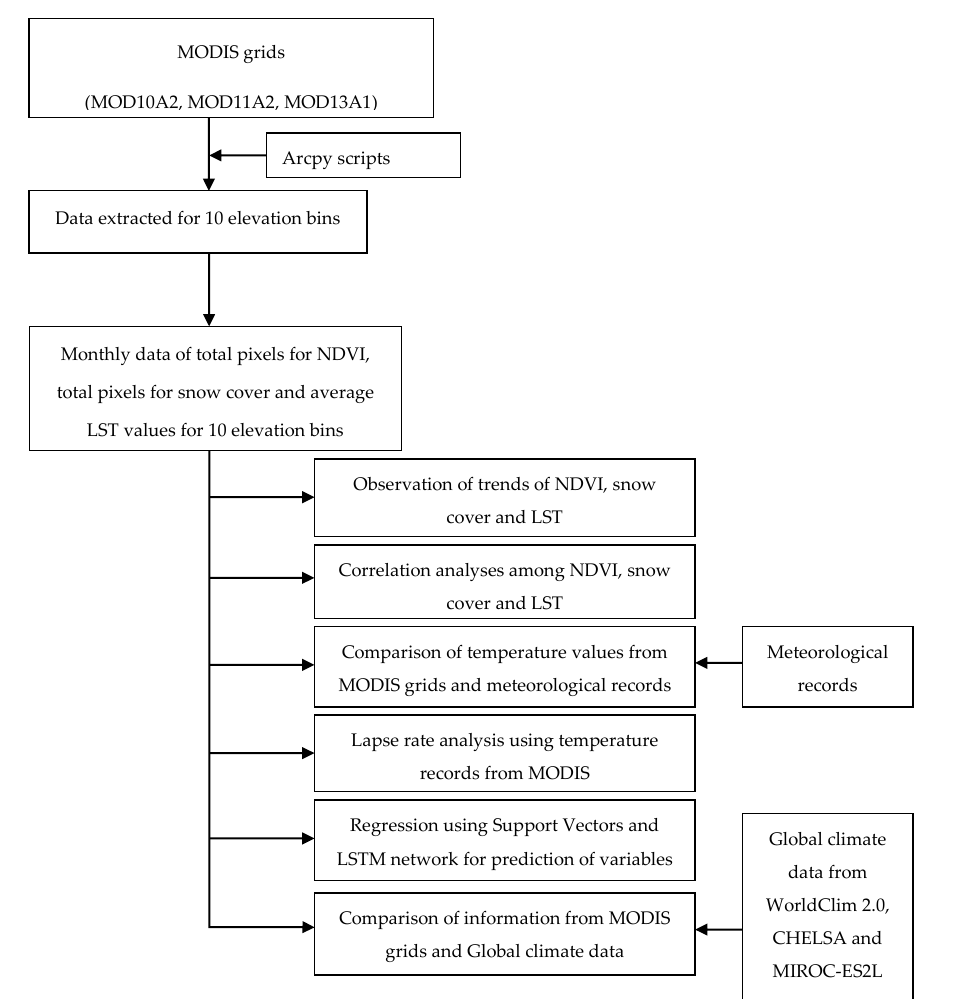
Figure 2. Methodological flow chart to explain step wise process followed in this study.